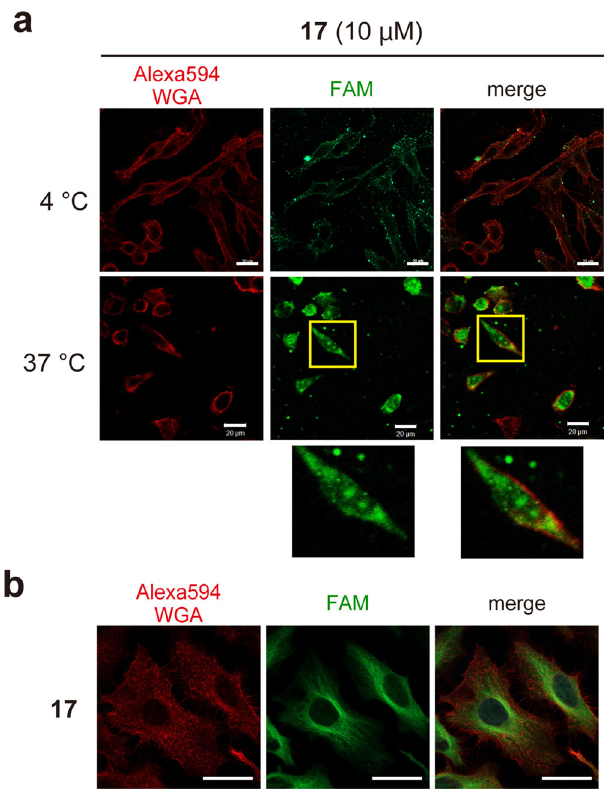
Fig. 6 Cytosolic delivery of IgG conjugated with ε -P α L. a HeLa cells were incubated with ε -P α L-mAb FAM ( 17 ) for 120 min at 37 °C and 4 °C. After washing and fi xing the cells, the cellular localization of 17 (green) was determined by CM. The cell membrane was stained with Alexa594-WGA (red). Representative CM images and magni fi ed views of the yellow-boxed areas are shown. Scale bars, 20 µ m. b immunostaining of α -tubulin by 17 in HeLa cells. The cells were fi xed with 4% paraformaldehyde, permeabilized in 0.1% Triton X-100 in PBS, then blocked in a blocking reagent (Blocking One). The cells were then incubated with 17 at 2 μ g ml − 1 (shown in green) for 60 min at 25 °C. The cell membrane was stained with Alexa594-WGA (red) after washing the cells, and the cells were then observed by CM. Scale bars, 20 µ